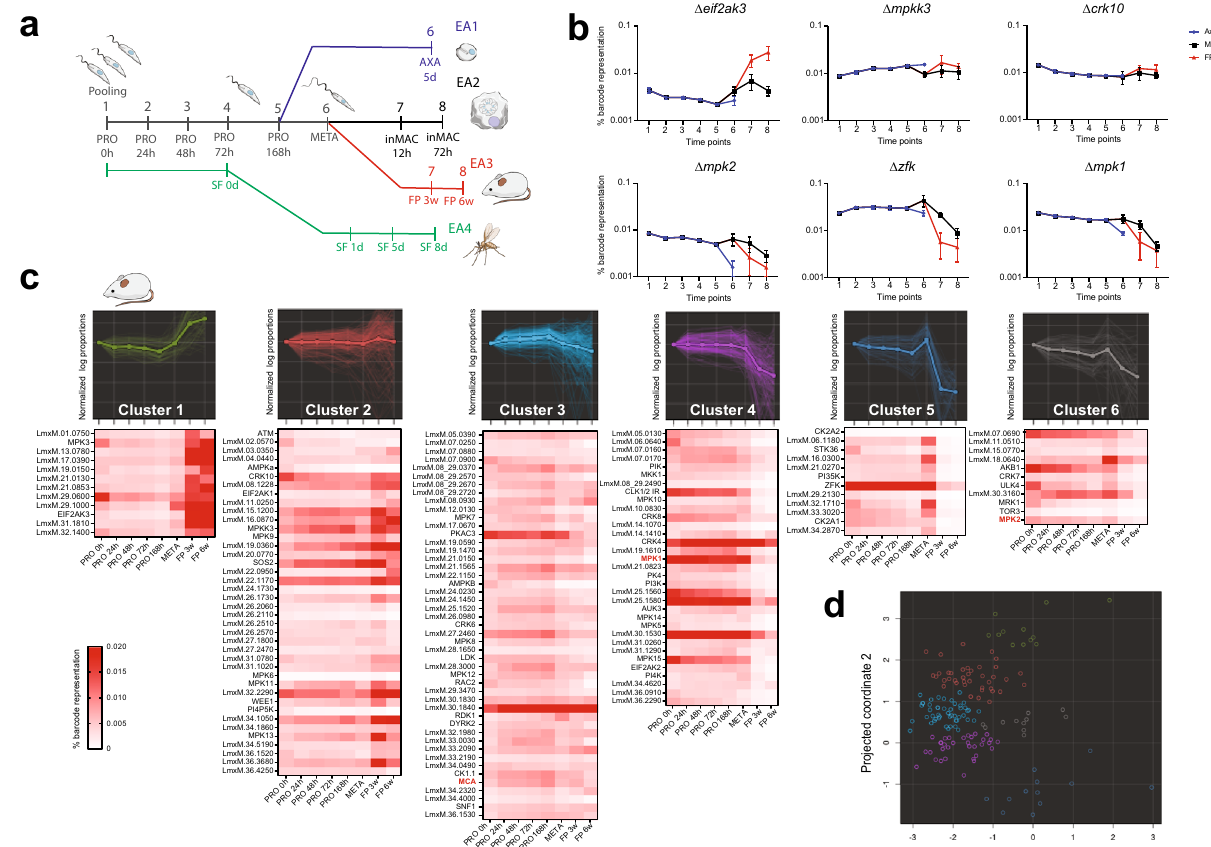
Fig. 4 Identi fi cation of protein kinases involved in L. mexicana differentiation and infection. a Schematic illustration of the bar-seq screen design with three experimental arms (EA1, blue; EA2, black; EA3, red) depicting investigation of differentiation to amastigote stages and investigation of protein kinase mutants in sand fl y (SF) infection (EA4, green). A pool of gene deletion mutants was generated in procyclic promastigotes (PRO), which were grown in Graces Media at pH 5.5 for 168 h. Cells were then either diluted into amastigote media at 35 °C and grown as axenic amastigotes (AXA) for 5 d or enriched for metacyclic promastigotes. Metacyclic promastigotes (META) were used to either infect macrophages (inMAC) or inoculate mouse footpads (FP). DNA was taken at the indicated time points and the unique barcodes ampli fi ed by PCR to apply bar-seq analyses. b Proportion of barcodes across 8 time points, as indicated in a. The trajectories of six exemplar protein kinase mutants have been plotted for the three experimental arms. Values are mean ± S.D., n = 6 biologically independent samples. Statistical analysis was multiple t -test corrected for multiple comparisons with post-Holm – Sidak method. c Projection pursuit cluster analysis was applied to the trajectories from each experimental arm, grouped into six clusters, each consisting of trajectories with a similar trend. Only clusters resulting from the mouse footpad infection are shown. The image for each cluster shows gene trajectories overlaid with average trends in bold. Trajectories plotted using logged % barcode representation data, normalised to time 0. Heat maps below show % barcode representation data and depict the trend for each individual gene. Gene IDs in red (MCA, MPK1 and MPK2) have documented phenotypes in Leishmania and serve to benchmark the dataset. d The relationship between the clusters is shown on a two-dimensional PCA plot. Colours match the clusters in c